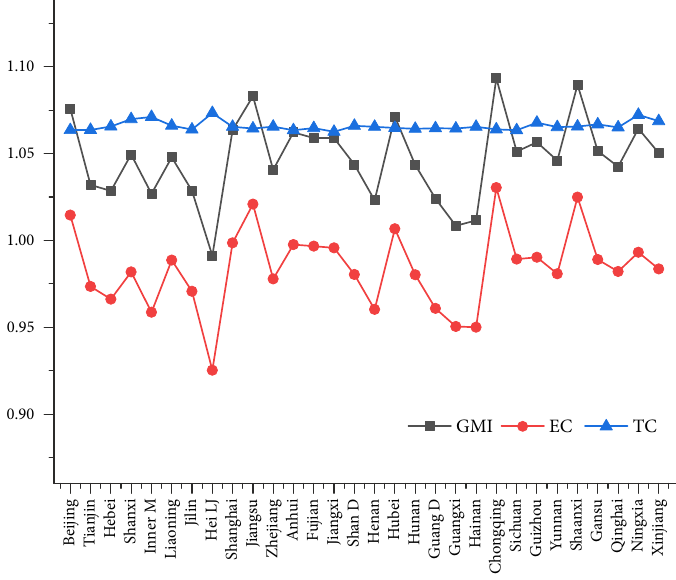
Figure 5. EC and TC of different